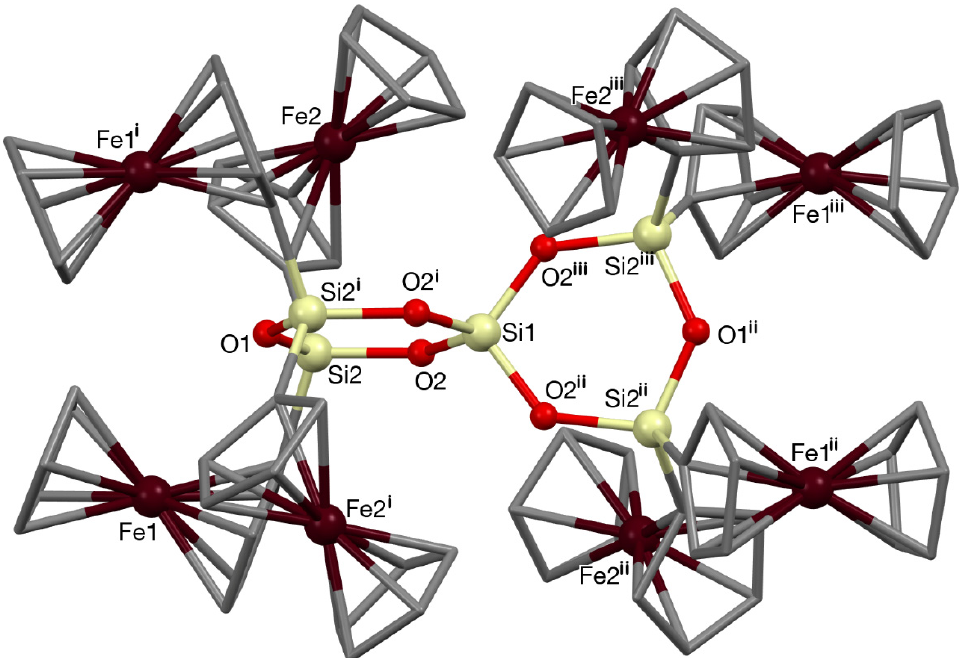
Figure 2. Molecular plot of the crystal structure of compound 4 with selected atoms labeled (symmetry operations: (i) − x + 1/2, − y + 1/2, z; (ii) y, − x + 1/2, − z + 3/2; (iii) − y + 1/2, x, − z+3/2) . Hydrogen atoms and the solvent molecule have been omitted for clarity.